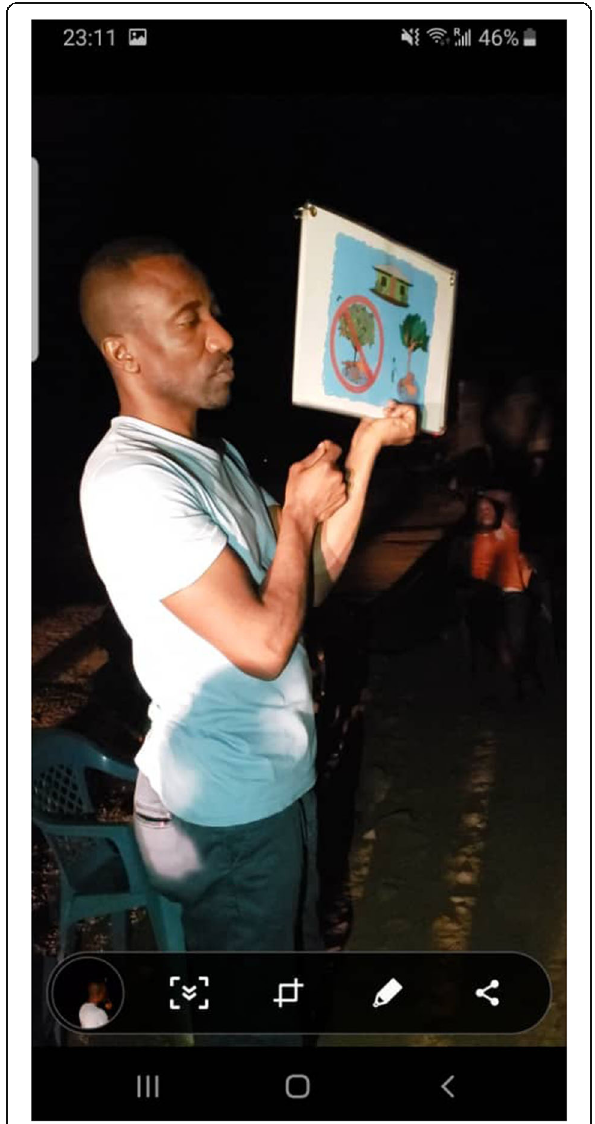
Fig. 7 Community Engagement in DRC: Sharing Living Safely with Bats with partner communities: Talking points included themes such as bats as essential agents in the local